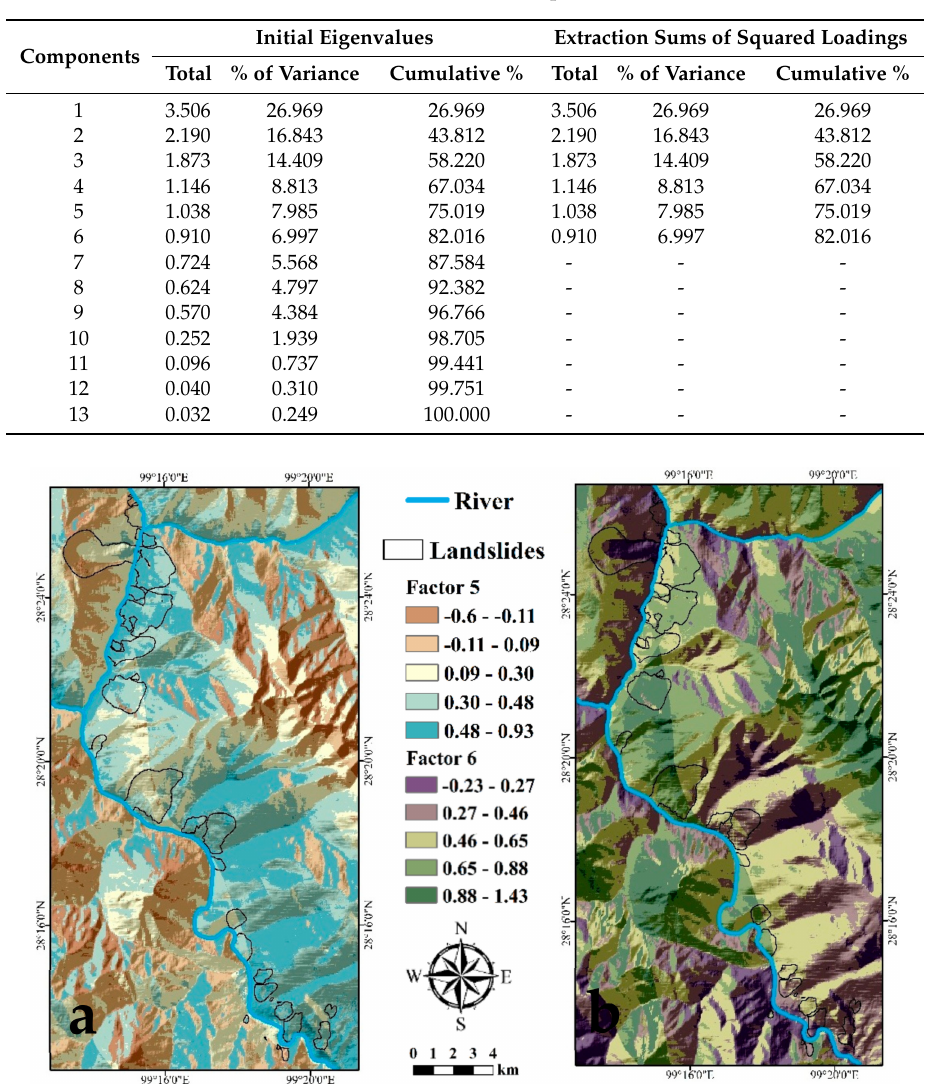
Table 5. Total variance explained.